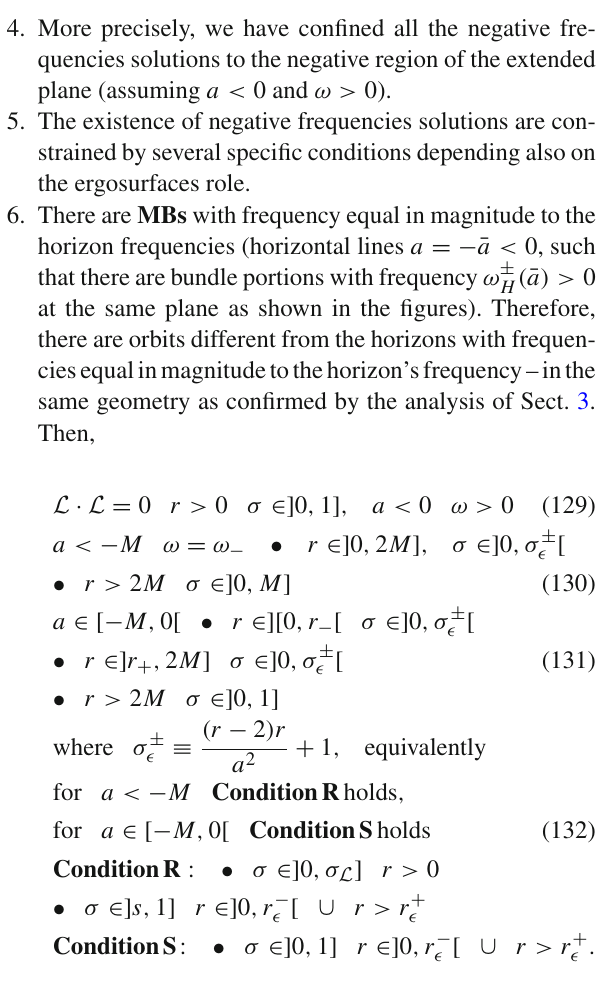
retrograde photon motion represented by the solutions in the sector a < 0 of the extended plane, assuming ω > 0. It is clear the absence of tangency points with the horizon on the extended plane and the coin- cidence with the bundles with equal magnitude origin a + with equal frequency on the extended plane sector a 0 >